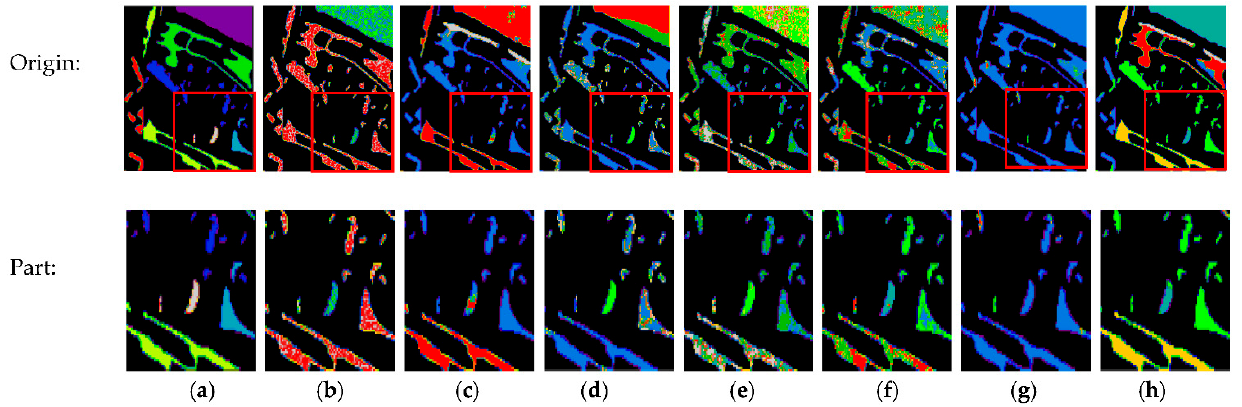
Figure 9. Clustering results obtained using different methods on the Pavia Center data set with salt and pepper noise. ( a ) Ground truth. ( b ) LRSC 38.21%. ( c ) SSC 50.39%. ( d ) S4C 52.38%. € EDSC 60.33%. ( f ) EGCSC 64.22%. ( g ) EKGCSC 33.68%. ( h ) MEKGCSC 85.01%.